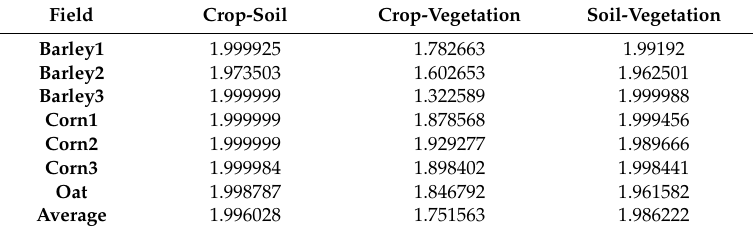
Table 7. Je ff ries–Matusita distance between the three classes computed with the pixel-based image